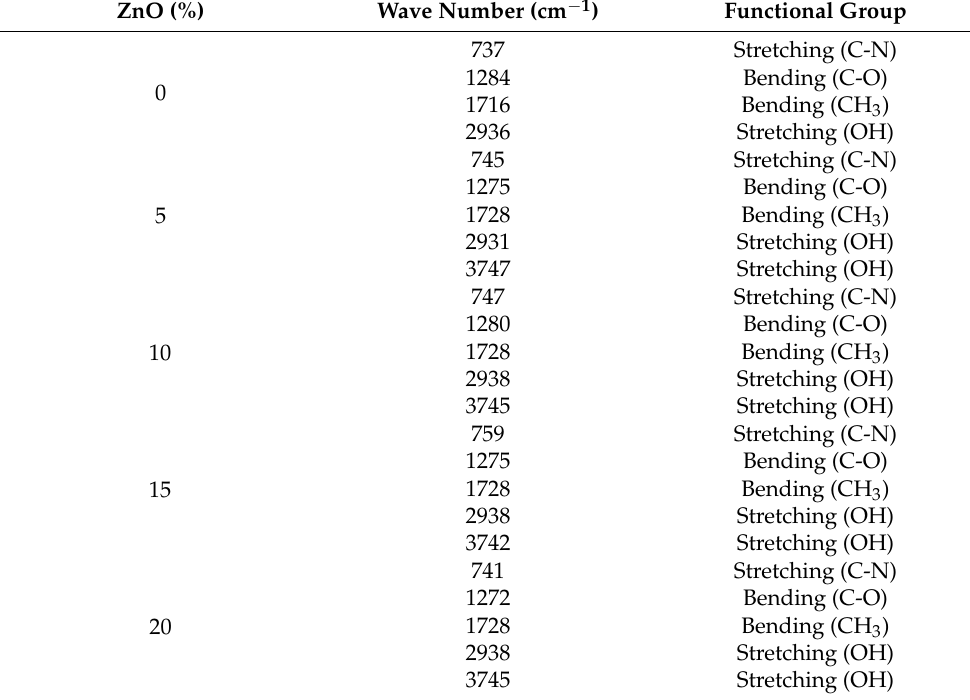
Table 2. Functional group of ZnO.